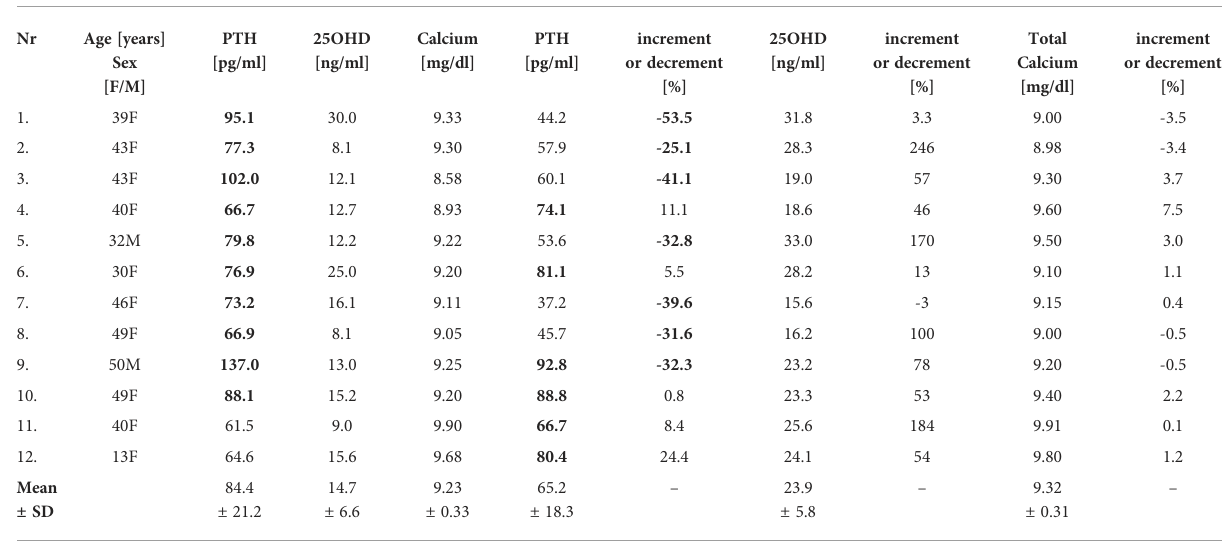
TABLE 4 Individual concentrations of PTH, 25OHD and total Calcium of patients with raised PTH (either in March/April, n=10, or in September/ October, n=6), the fall in PTH (spring versus autumn) and an increase in 25OHD were statistically signi fi cant